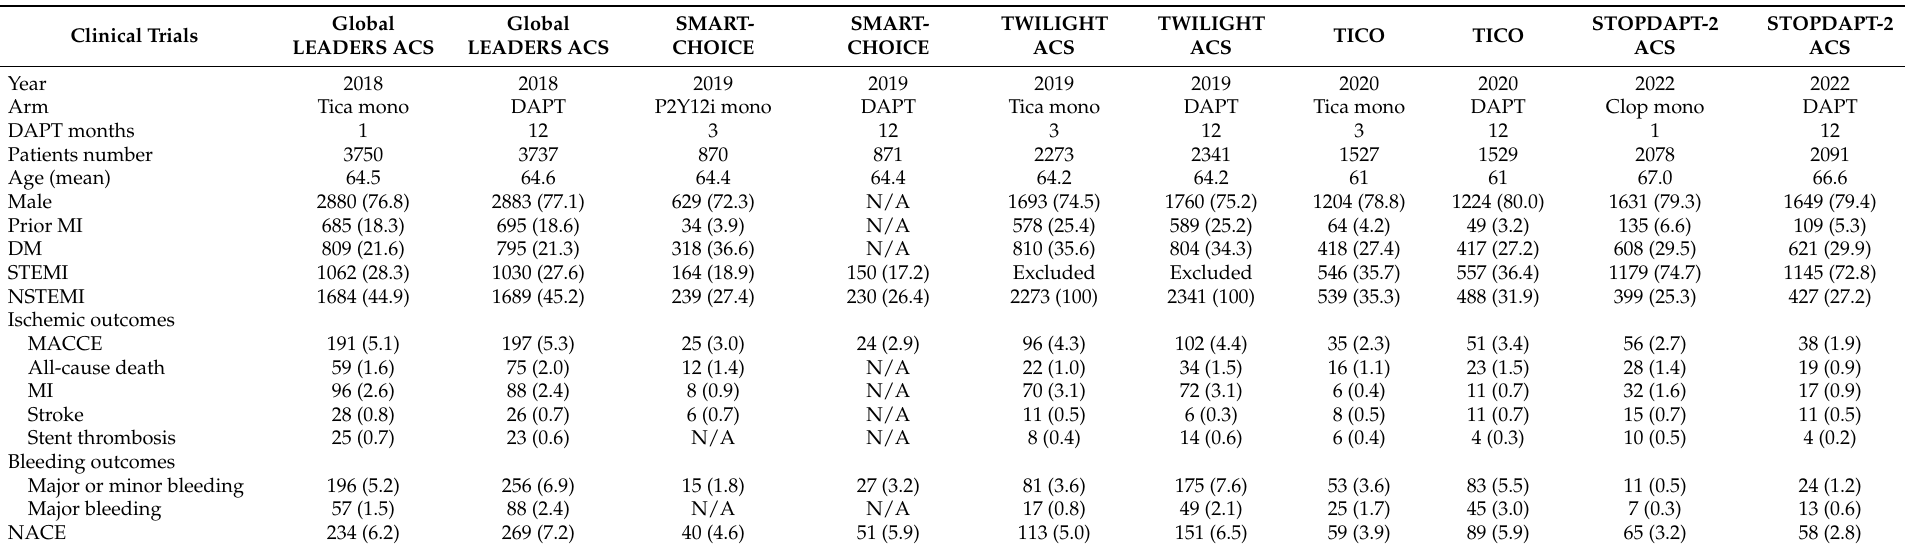
Table 1. Clinical characteristics and outcomes of included randomized